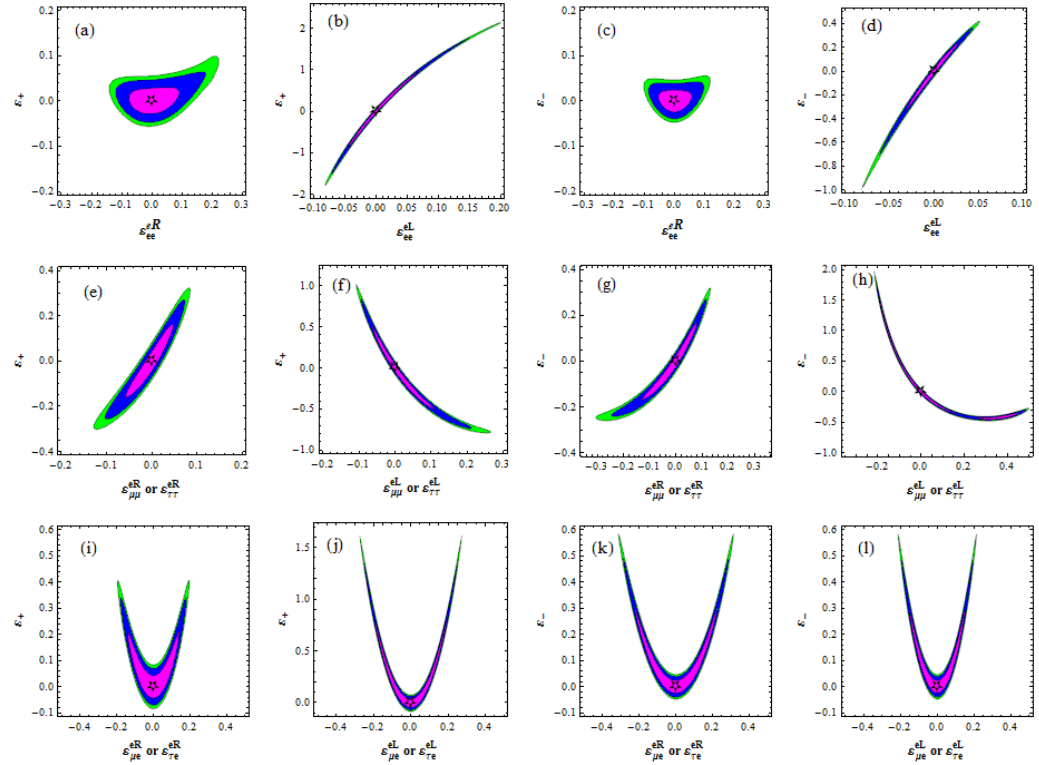
Figure 8 . Future prospects: future prospect boundaries on combined source and detector NSI parameter correlations at 68% (magenta), 90% (blue), and 95% (green). For the detector FC NSI parameters from (i) to (l), the C.L. regions of " eR etc. are the same as those of the parameters e(cid:22) shown because of the hermiticity of the leptonic